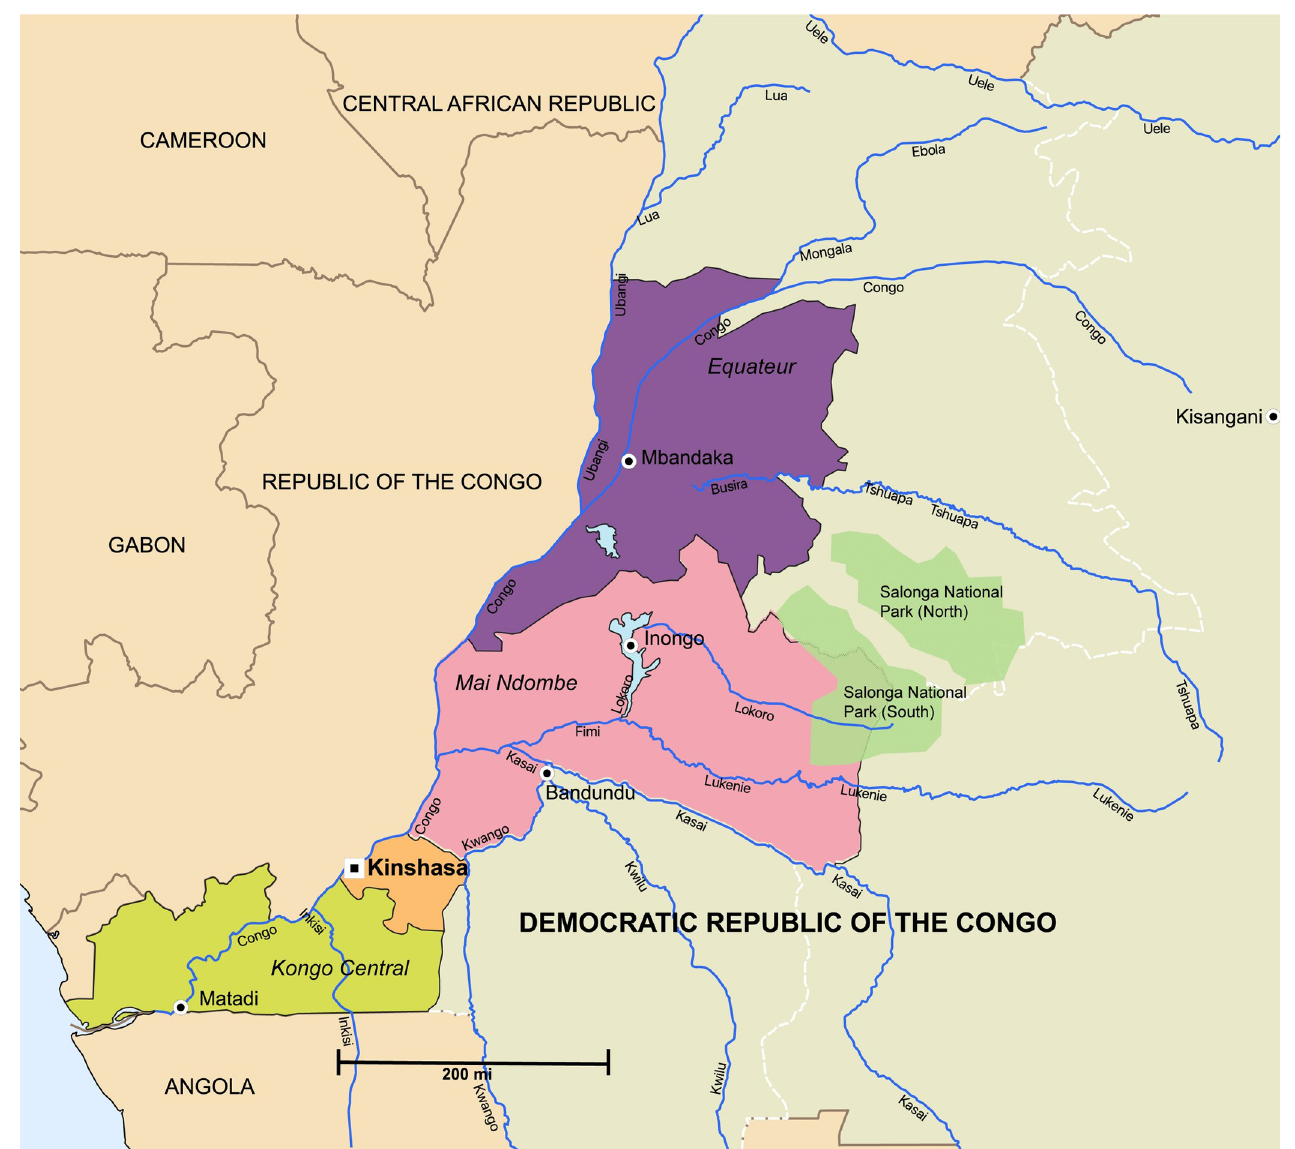
Fig 2. Regional map of the three main provinces for export of bushmeat to Kinshasa markets. Illustration showing participant-indicated provinces where bushmeat is sourced for hunting, transport and sale in Kinshasa bushmeat markets. Kinshasa is both a province and a city, with the former indicated by the white and black square and the latter in orange. Capital cities of each province are indicated by white and black circles and province names are italicized. Former province borders (the six largest were split in 2015) are indicated with a white dashed line.